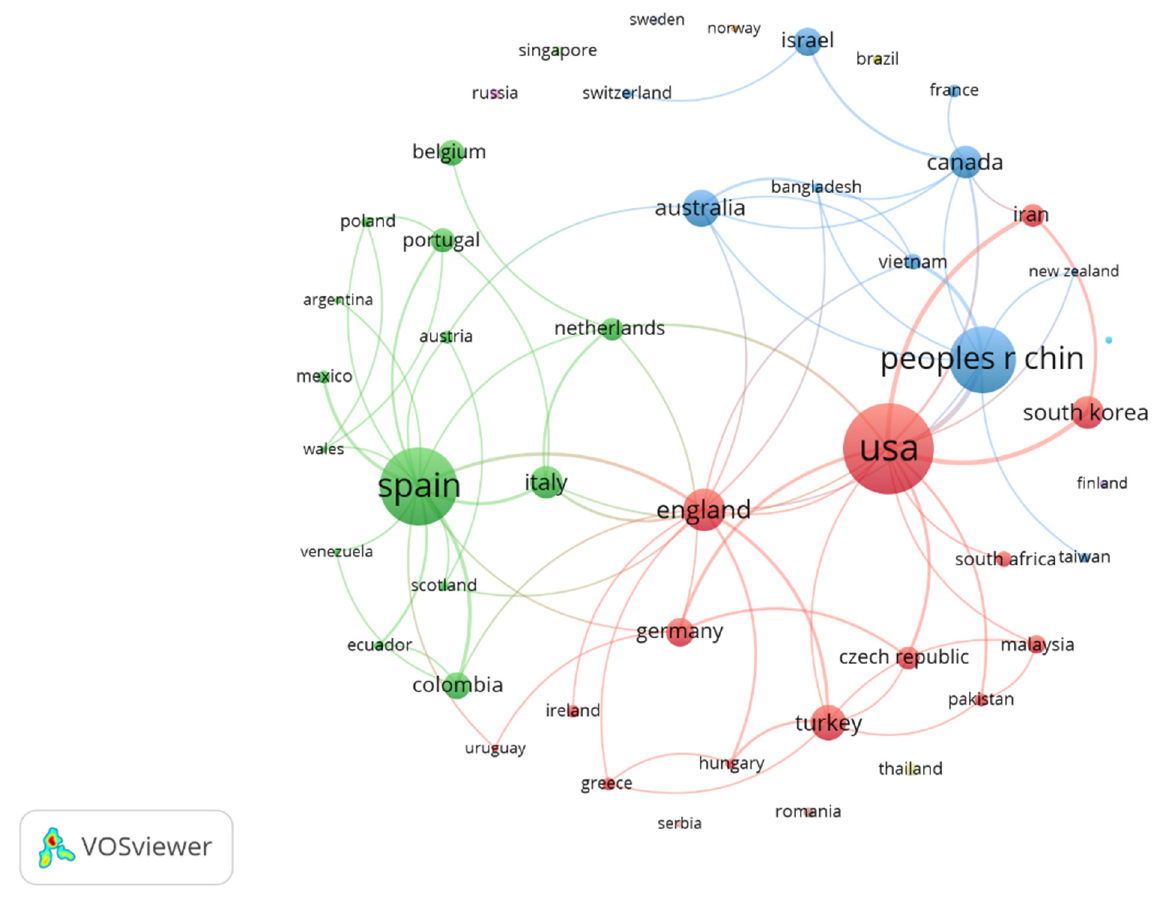
Figure 3. Graph with co-authored countries/regions: clusters formed by countries/regions; node size (documents).